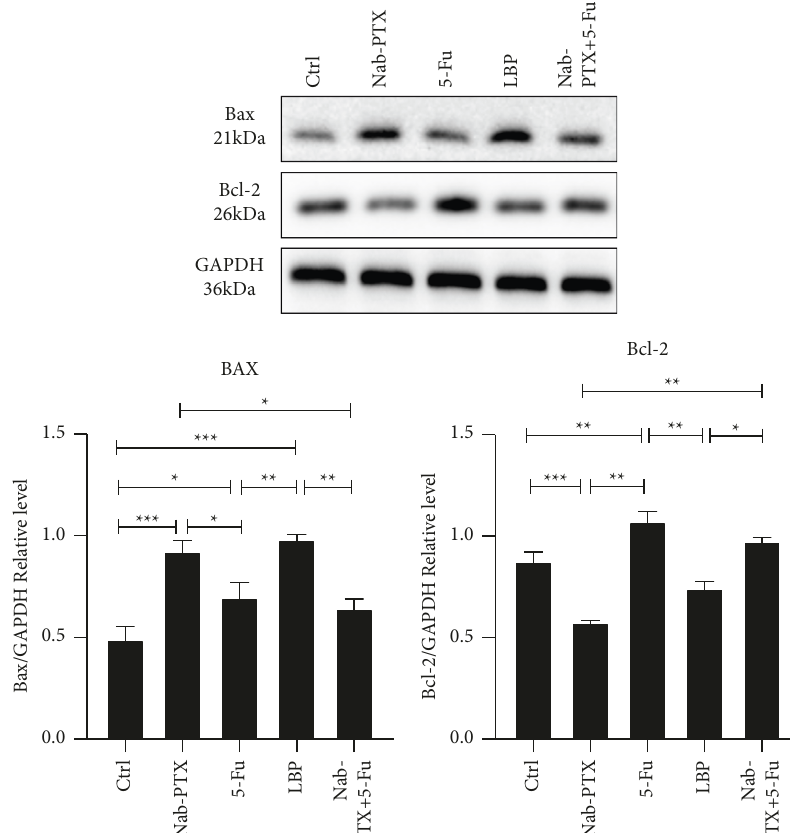
Figure 5: The effect of each group on apoptosis of AGS cell line. Treat gastric cancer cells with Nab-PTX (0.2 μ mol/l), 5-Fu (2 μ mol/l), LBP (10 μ mol/l), and Nab-PTX+5-Fu (0.2 μ mol/l +2 μ mol/l) for 24 hours. After extracting protein, the WB experiment was performed. WB results showed the protein expression of Bax and Bcl-2. All the above experiments were repeated at least three times independently. ∗ P < 0 . 05, ∗∗ P < 0 . 01, P < 0 .